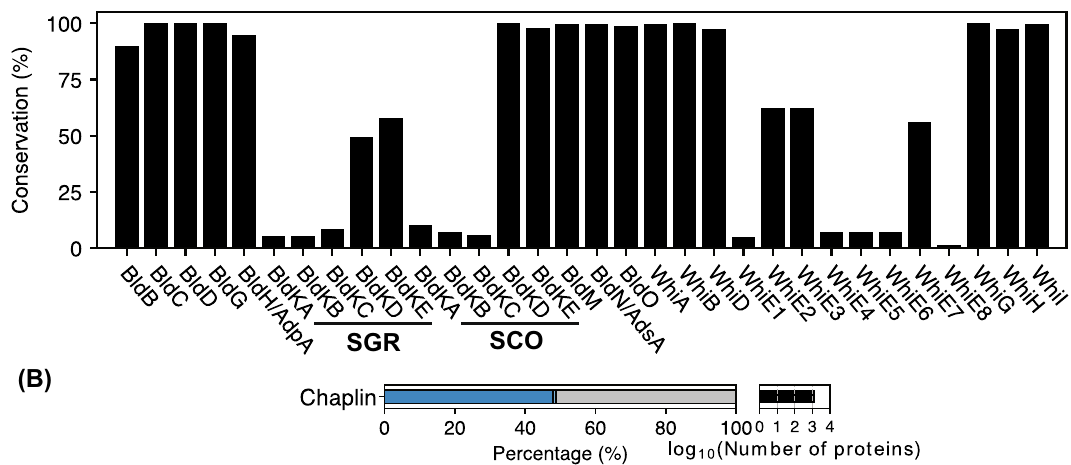
Figure 6. ( A ) Conservation of Bld and Whi proteins. ( B ) The total number of proteins in chaplin family and the percentage in each conservation bin. The colour codes are the same as those in Fig.